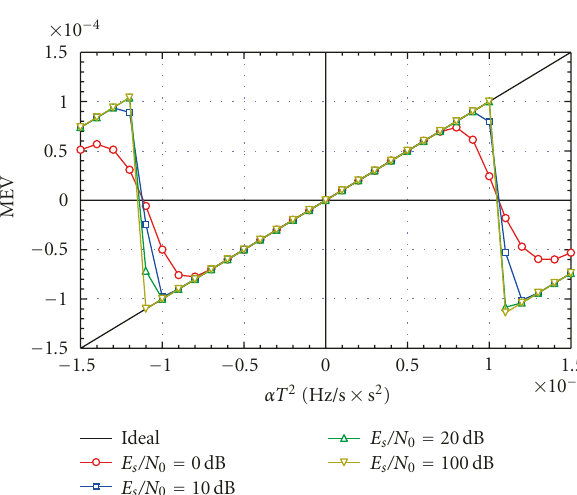
Figure 5: MEV of FREPE estimator for di ff erent values of E S /N 0 — simulation only. Preamble + postamble DA ML phase estimation, N = 44, M = 385, vT = 1 . 0 × 10 − 3 .